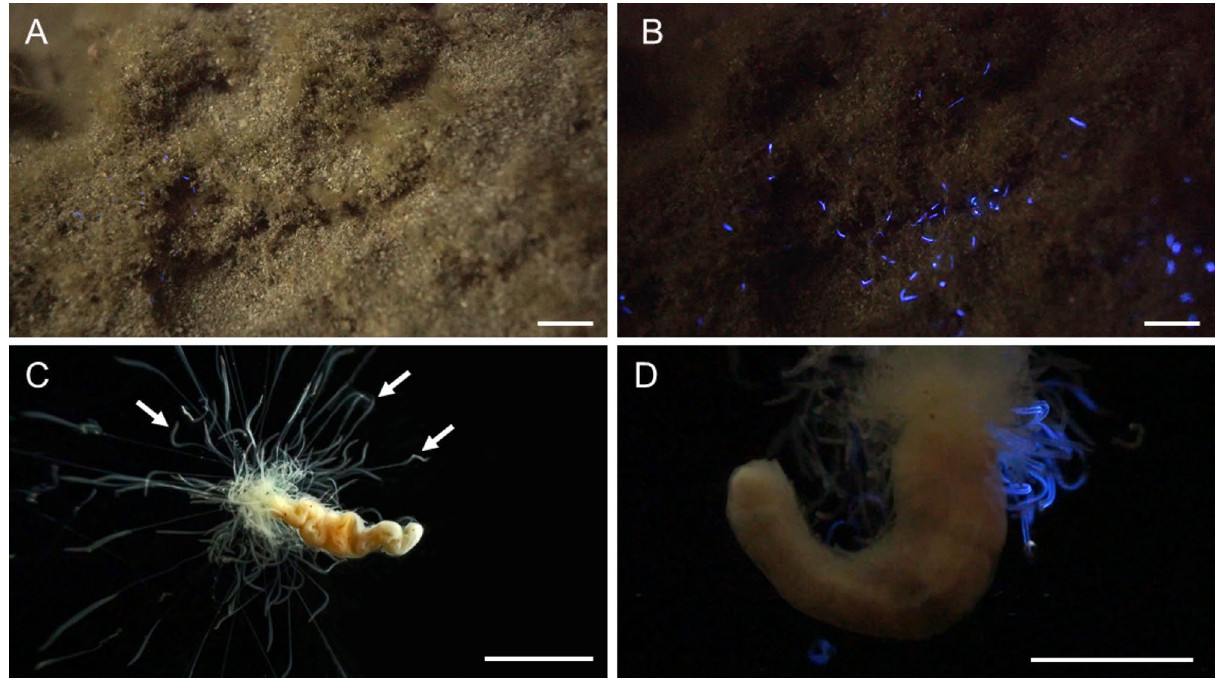
Figure 1. Photographs of Polycirrus sp. ISK. ( A ) Polycirrus sp. ISK in its natural habitat with bright-field illumination. ( B ) Bioluminescence of Polycirrus sp. ISK in its natural habitat without bright-field illumination. The worms were stimulated by air bubbling from SCUBA gear. ( C ) A single worm with stretched tentacles. Tentacles are indicated by white arrows. ( D ) The worm with light emission at the tentacles. This worm was stimulated by an electric shock. Scale bars = 100 mm for A and B, 10 mm for C and D. Each photograph was extracted from the videos recorded with the following settings: sensitivity, ISO 51200 or 11 lx; white balance, 4300 K or 5800 K; shutter speed, 1/30 s or 1/60 s; iris, F1.8-3.5; frame rate, 29.97 fps or 60 i; frame size, 1920 × 1080 pixels. Original high quality videos are available at https:// youtu. be/ KEsU0 kWAEfg and https:// youtu. be/ 24dxv